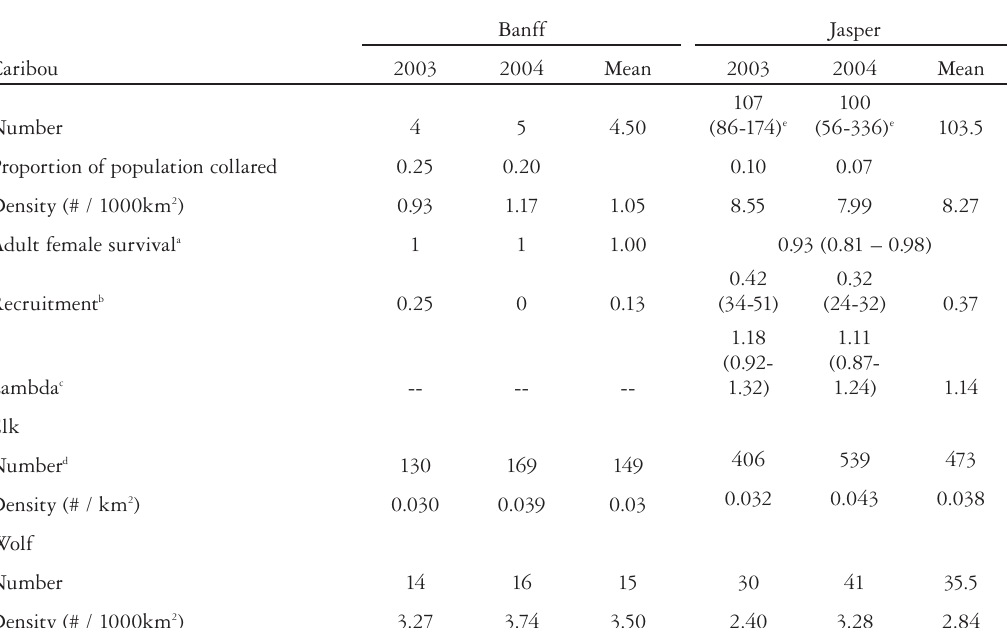
Table 1. Summary table of caribou demography and caribou, wolf and elk density for the Banff National Park and Jasper National Park caribou sub-populations, 2003 – 2004. The Banff and Jasper study areas were 4283 km 2 and 12 512 km 2 in size,